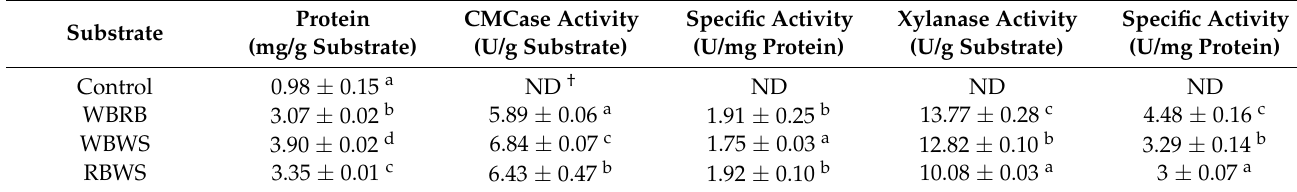
Table 2. Production profile of protein and lignocellulolytic enzyme activities produced by solid-state fermentation of different agro-industrial waste as substrates 1